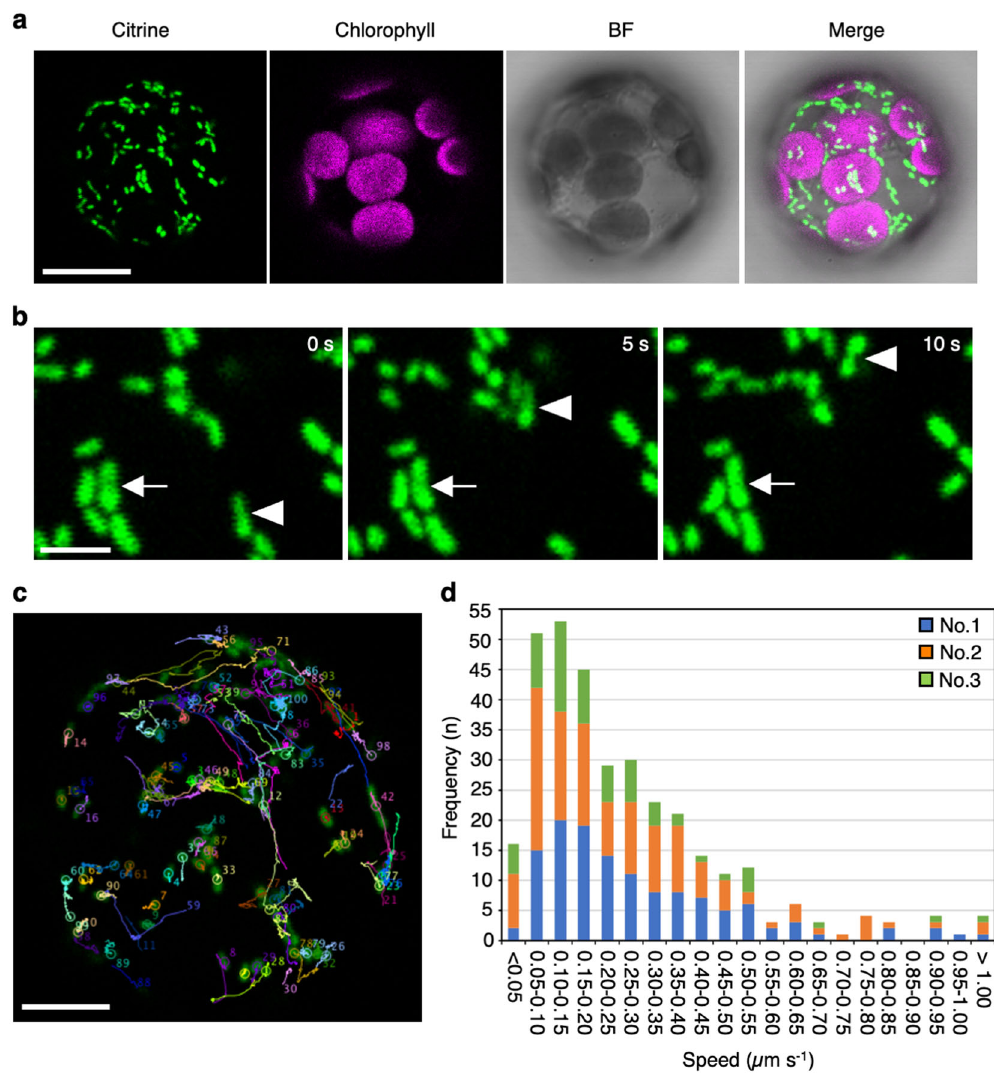
Fig. 1 Observation of mitochondrial movement in mesophyll protoplasts. a Citrine fl uorescence in mitochondria (green) and chlorophyll auto fl uorescence (magenta), and bright fi eld (BF) image of mesophyll protoplasts of MTS-Citrine transgenic A. thaliana are shown as a merged image (Merge) taken by CLSM. Scale bar: 10 µ m. b Time-lapse images of mitochondria taken every 5 s. Fast, directional movements (arrowheads) and slow, wiggling movements (arrows) of mitochondria are shown. Scale bar: 2 µ m. c Representative images showing the trajectories of mitochondrial movements over a 30-s period. Mitochondrial movements were tracked and quanti fi ed using Fiji software and its plugin MTrackJ. Mitochondria are labeled with numbers and outlined with different colored lines. Scale bar: 10 µ m. d Speed distribution of mitochondrial movement from three independent protoplasts (protoplast No. 1, blue; protoplast No. 2, orange; and protoplast No. 3,